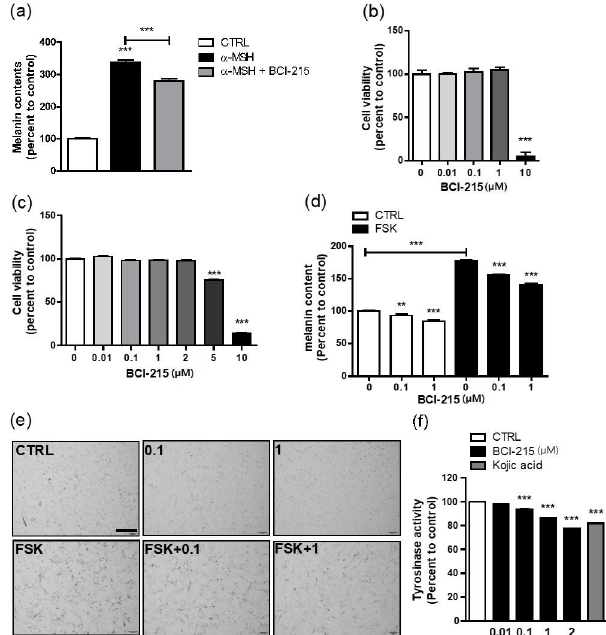
Figure 2. Cellular viability and the effect of BCI-215 on the melanin content and cellular tyrosinase activity. ( a ) Anti-melanogenesis screening. Effect of 1 µM BCI-215 on the cellular melanin content of B16F10 cells stimulated with 100 ng/mL α -MSH for 72 h. Cellular viability was measured using a WST assay in B1610F cells ( b ) and Mel-ab cells ( c ) treated with 0.1 – 10 µM BCI-215. ( d ) Effect of BCI- 215 on melanin content in Mel-ab cells in the conditions of basal or forskolin (FSK) stimulation for 72 h. ( e ) Photographs of cells showing the effects of 0.1 and 1 µM BCI-215 on melanin content of Mel-ab cells in the conditions of basal or FSK stimulation for 72 h. ( f ) Effect of BCI-215 on cellular tyrosinase activity when Mel-ab cells were basally treated with 0.1, 1, and 2 µM BCI-215 for 72 h compared with 200 µM of a well-known whitening agent, kojic acid. ** p < 0.01, *** p < 0.001 vs. con- trols. 2.2. BCI-215 Does Not Downregulate the Transcription of MITF and Its Downstream Melano- genic Genes in a 24 h Frame